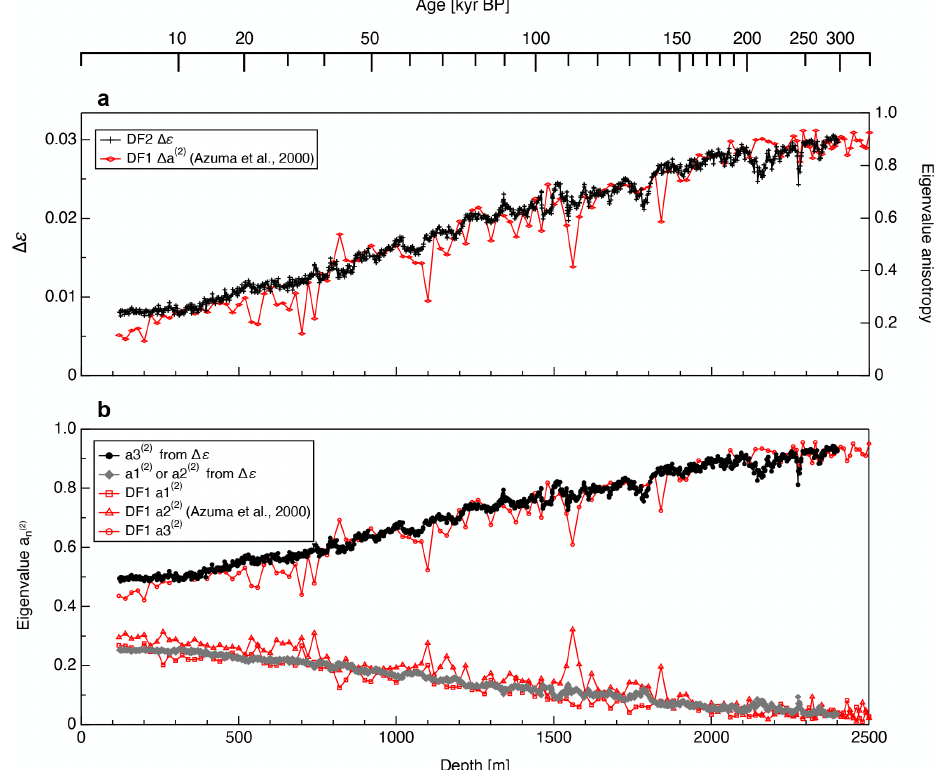
Figure 5. Comparison of eigenvalues obtained from the present dielectric measurements and from thin-section measurements. (a) The thick- section-based (cid:49)ε and optically derived (thin-section-based) eigenvalue anisotropy data for DF1, (b) a comparison of thick-section-based and thin-section-based normalized eigenvalue components. Black/gray and red lines indicate thick-section-based and thin-section-based values, respectively. The DF1 eigenvalues are taken from Azuma et al. (2000).